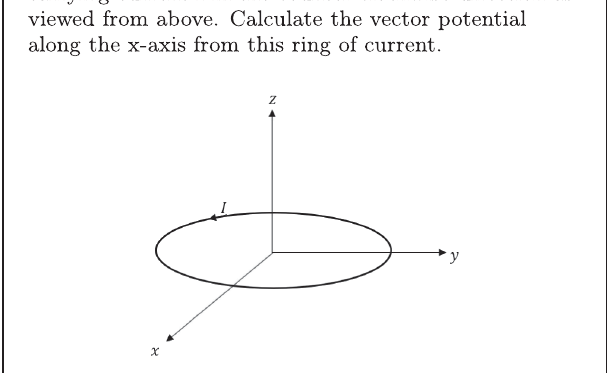
FIG. 2. The vector potential version of the interview question. For the Class. Mech. students, the distribution was described as a mass distribution with uniform λ (and the arrow indicating direction of current was removed), and students were asked to calculate the gravitational potential energy for a small mass placed on the x axis.